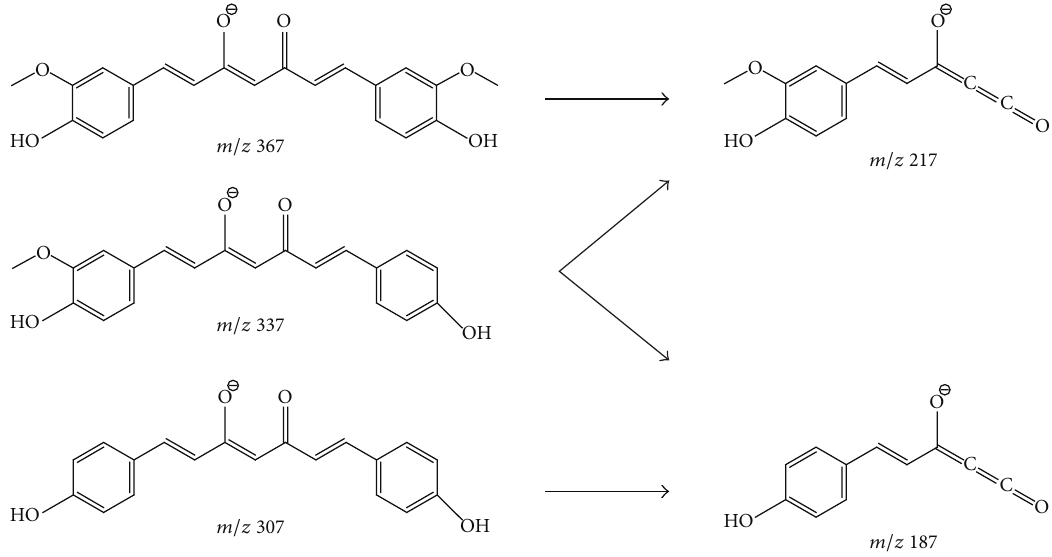
Scheme 2: Fragmentation pathway of curcuminoids (negative mode).